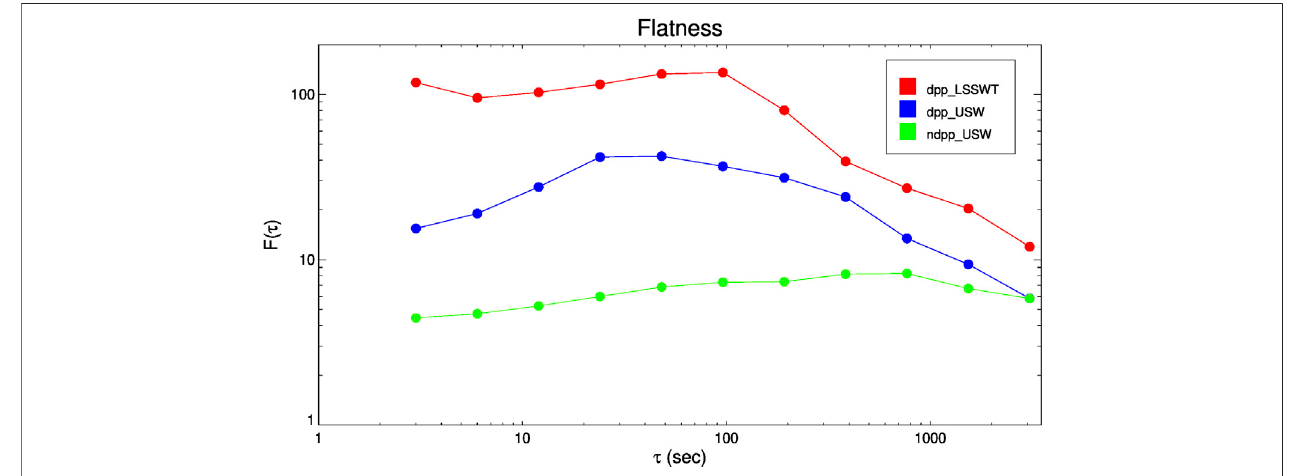
FIGURE 10 | The statistical distribution of the average values of fl atness factor F of 16 selected events observed in ndpp-USW region (green), dpp-USW region (blue), dpp-LSSWT region (red), respectively.